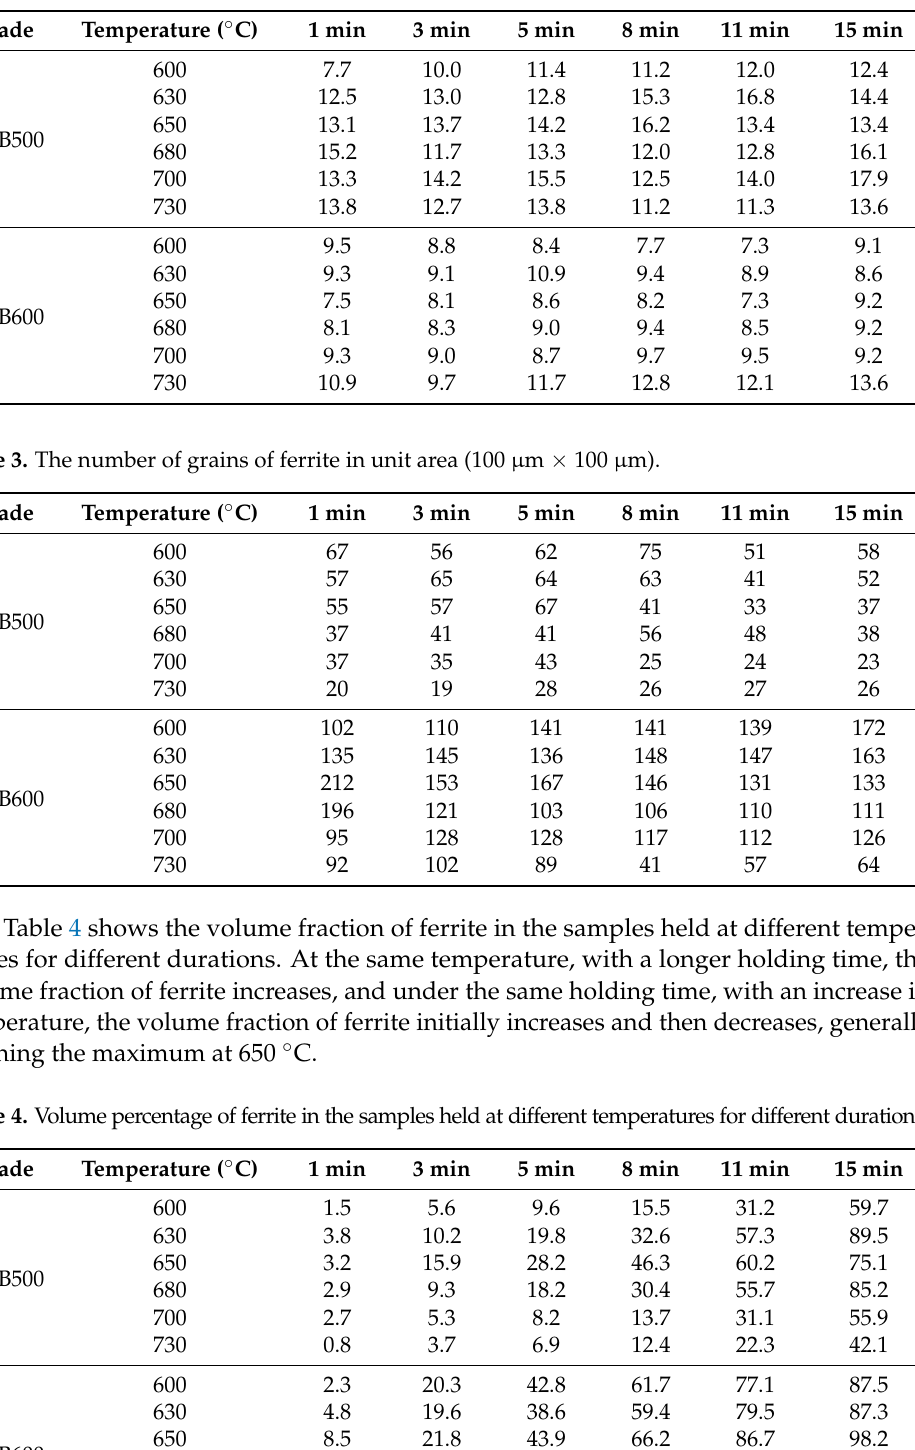
Table 2. Grain sizes of ferrite in the samples held at different temperatures for different durations (diameter, µ m).